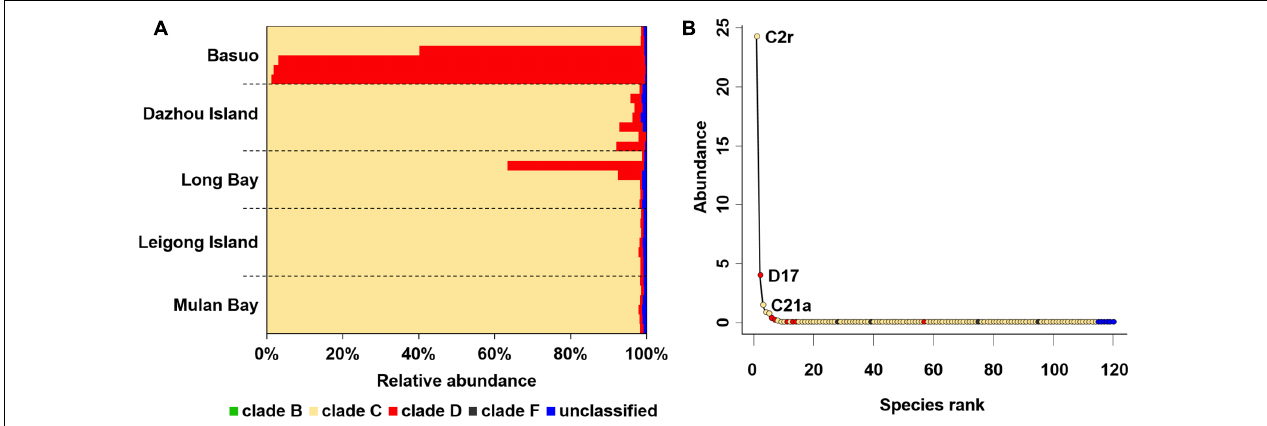
FIGURE 2 | Symbiodinium compositions for complete dataset. (A) Symbiodinium compositions at clade level. Bars represent the percentage of each clade. (B) Distribution of taxonomic abundances among Symbiodinium subclades.